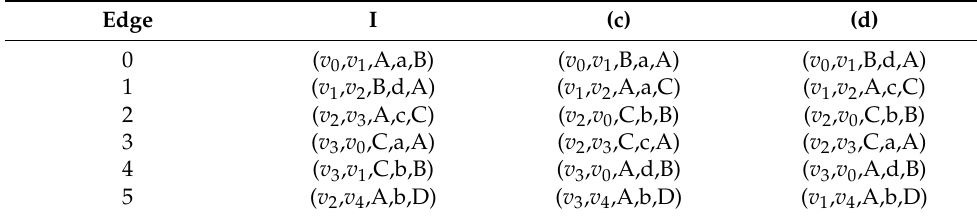
Table 1. Depth-first search code sequences.